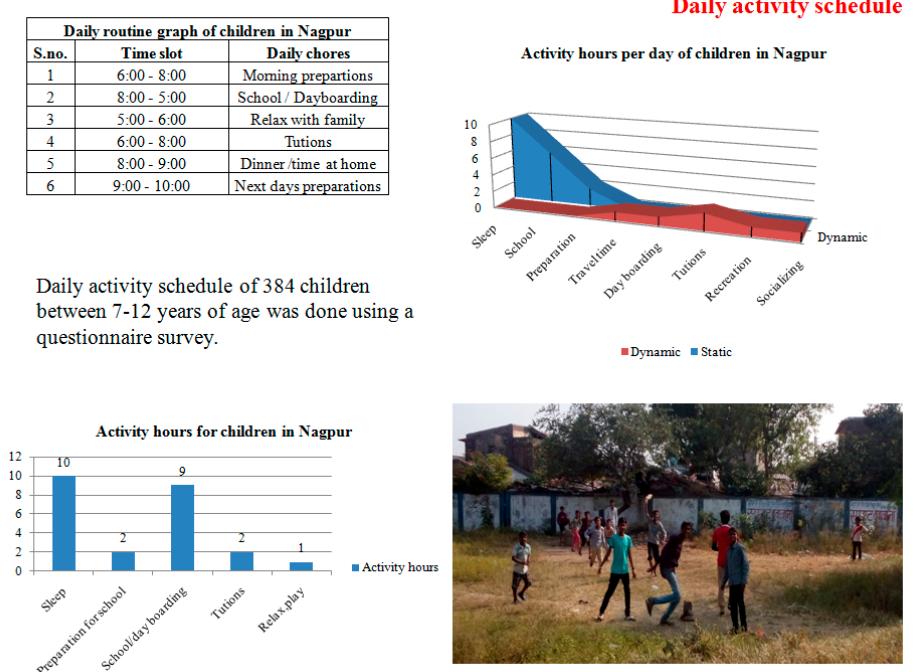
Figure 3. Children’s daily activity schedule survey.